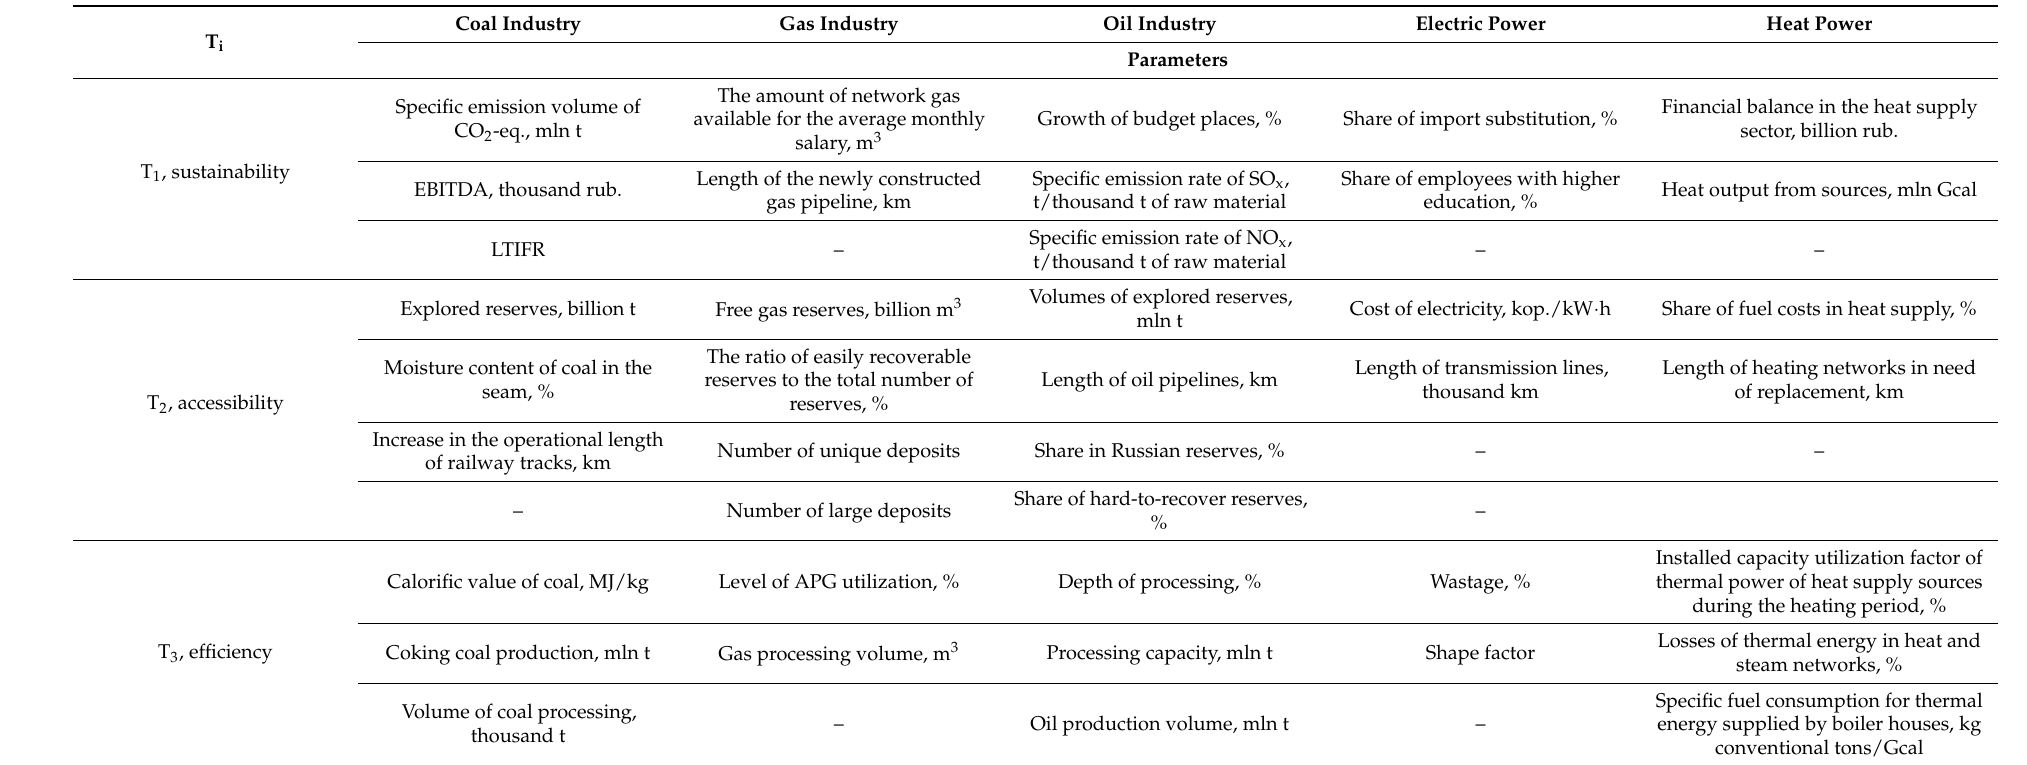
Table A1. Industrial parameters of